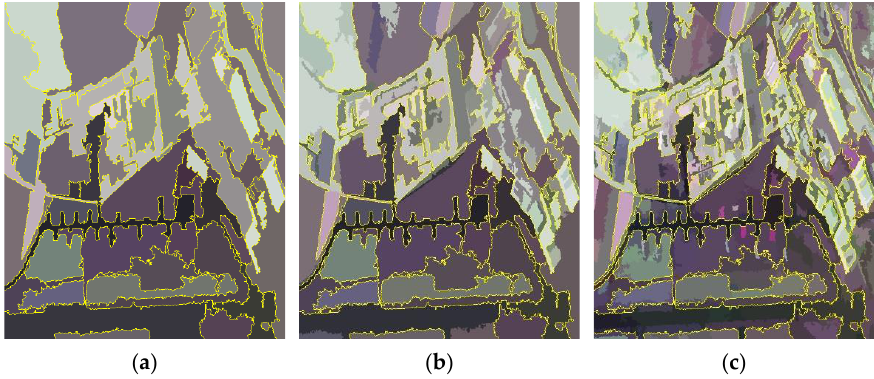
Figure 12. Superpixel results of the proposed method based on ESAR data, and K = 50, 100, and 500, respectively. ( a ) Averaged map when K=50 and the yellow lines are corresponding superpixel boundaries; ( b ) averaged map when K=100 while the yellow lines are superpixel boundaries when K = 50; ( c ) averaged map when K = 500 while the yellow lines are superpixel boundaries when K =